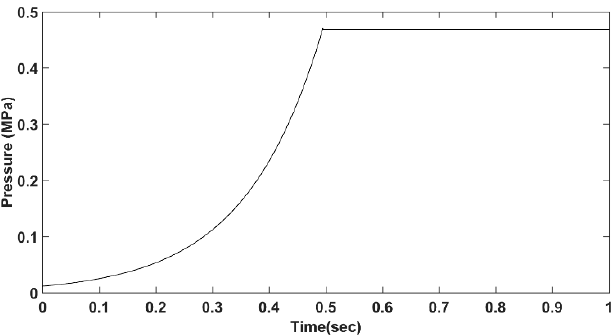
Figure 2. Non-linear clutch clamp load characteristics.